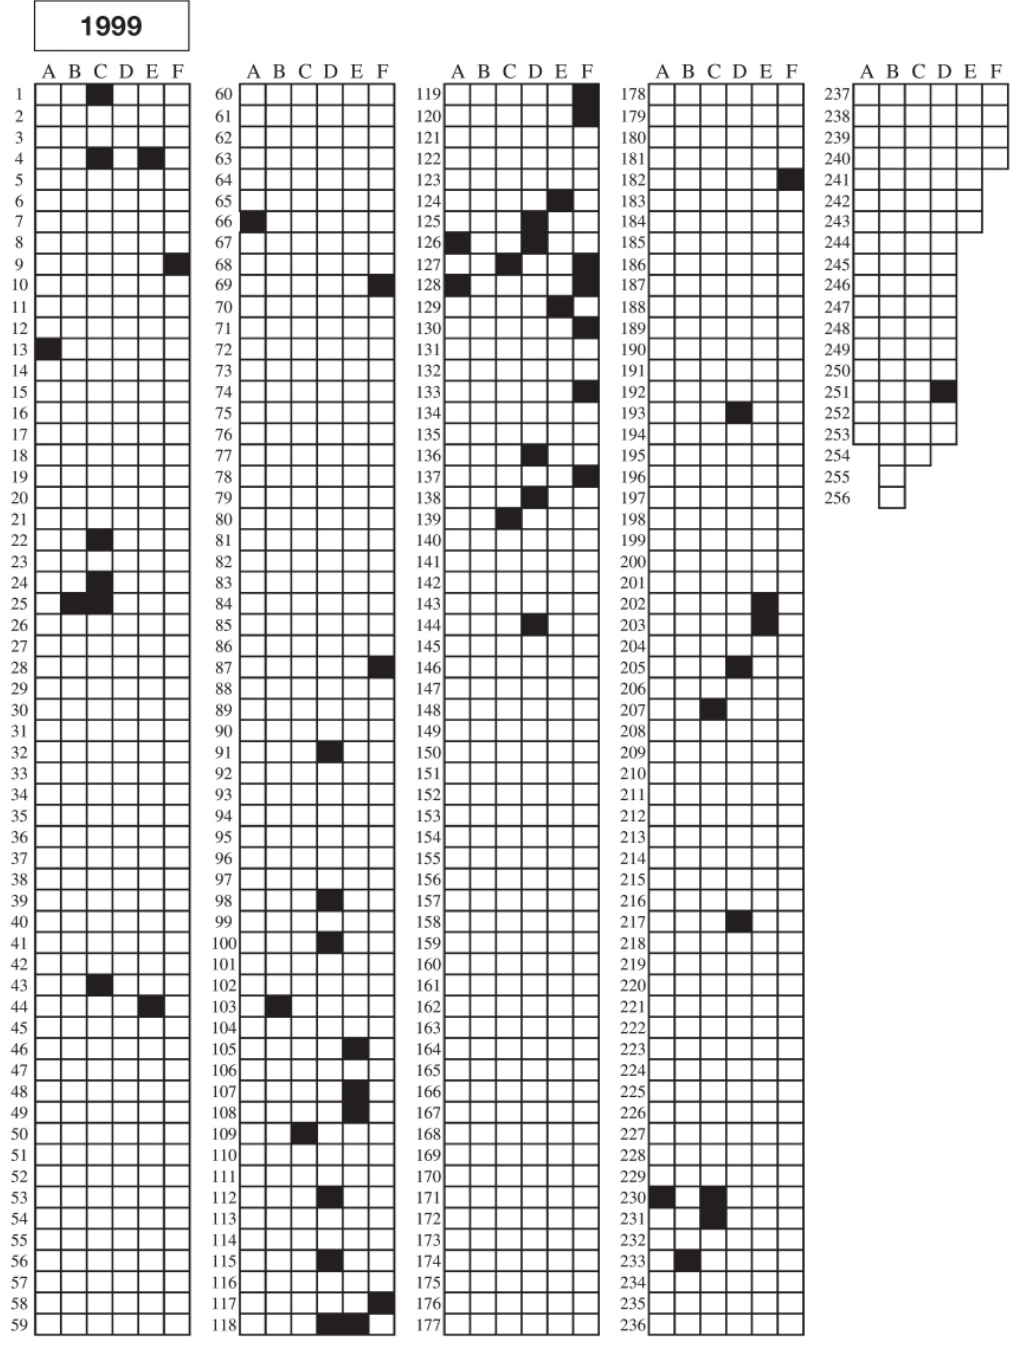
Fig. 5. Spatial pattern of esca-diseased plants in vineyard TB in the province of Ravenna in 1999 (first year of appearance of foliar esca symptoms in the vineyard). Black squares, symptomatic plants; open squares, asympto- matic